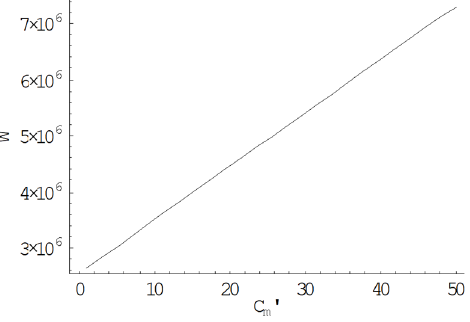
Figure 4. Total cost versus carbon emission parameter c m ’ .